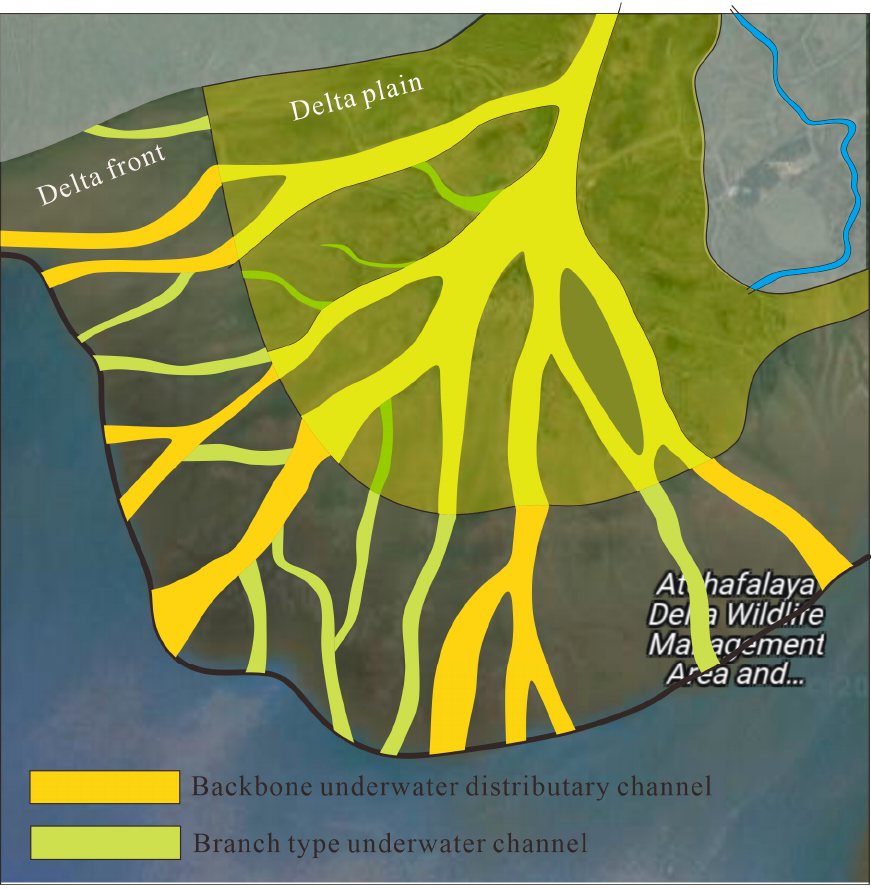
Figure 5. Sedimentary architecture model of Achafalaya Braided River delta.